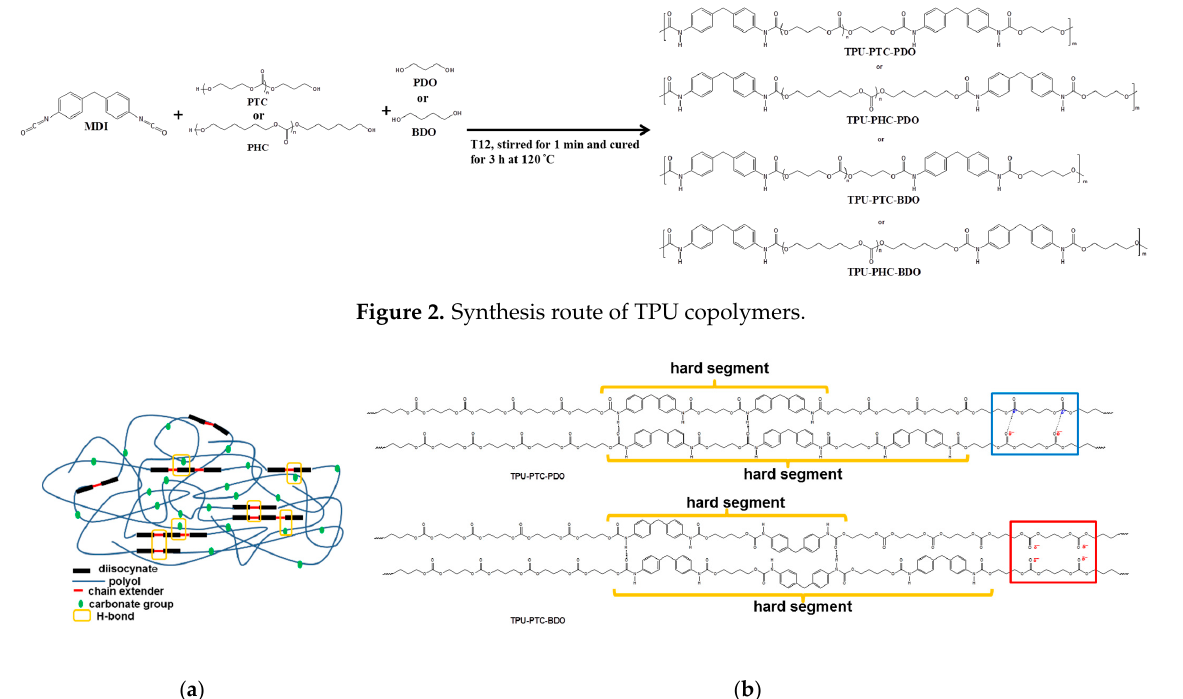
Scheme 1. ( a ) TPU ‐ PHC copolymers had strong intermolecular hydrogen bonds; ( b ) the regularity of the molecular chains in TPU ‐ PTC copolymers.